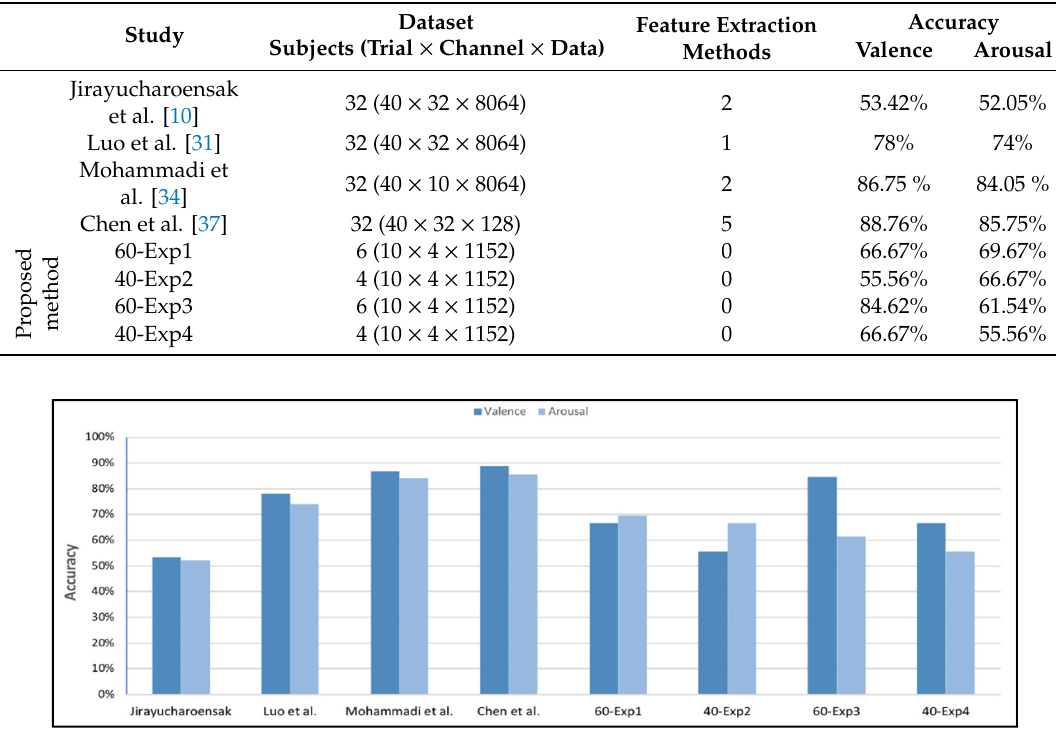
Table 4. Comparison with other studies that used the DEAP dataset.